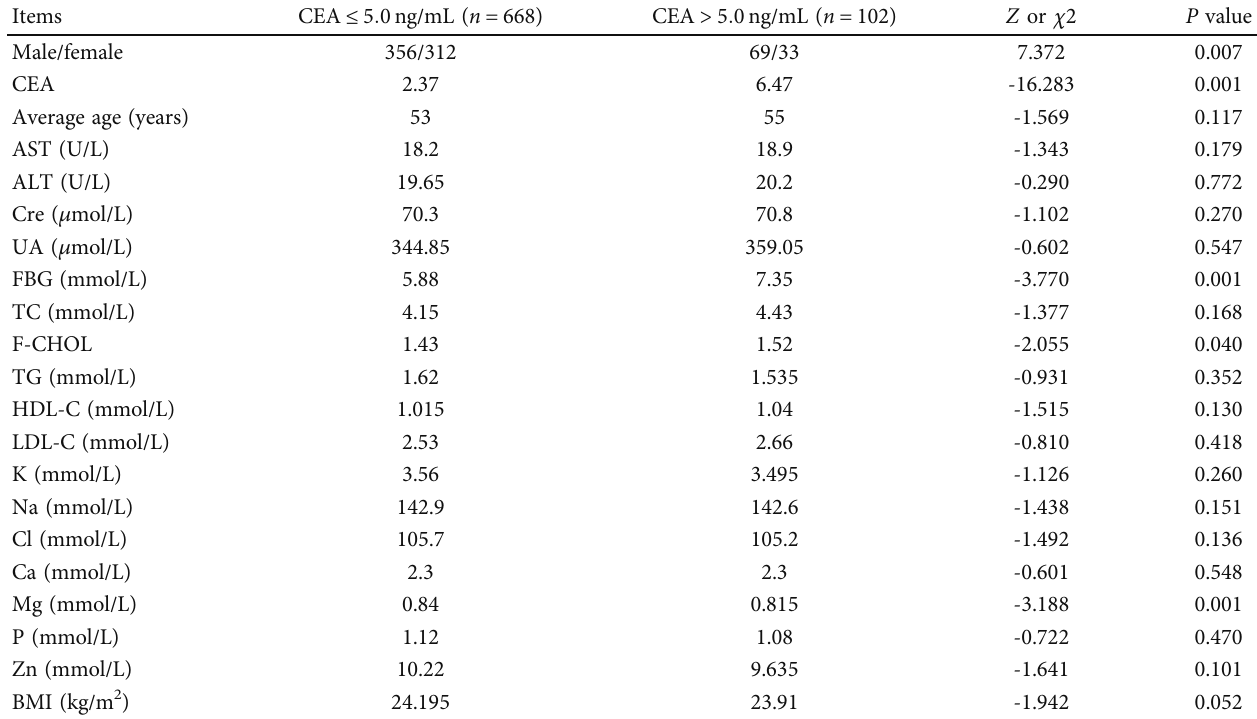
Table 7: Comparison of clinical data of patients in the CEA ≤ 5 : 0 ng/mL and CEA > 5 : 0 ng/mL